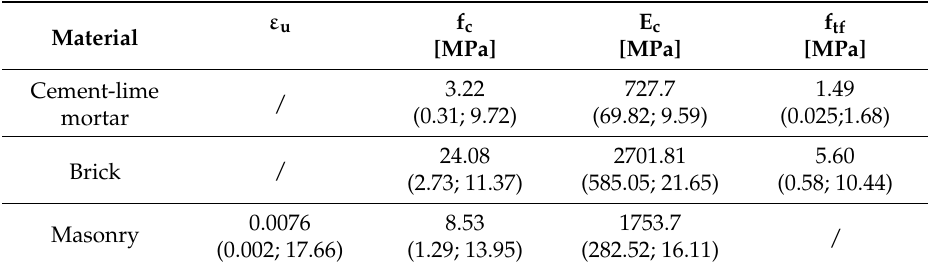
Table 1. Results of tests performed on bricks, cement-lime mortar, and masonry (standard deviation and coefficient of variation are reported in parentheses). ε u = failure strain; f c = compressive strength; E c = compressive Young modulus; f tf = tensile flexural